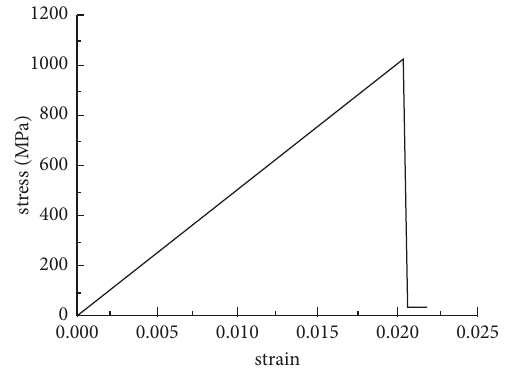
Figure 1: Stress-strain relationship of BFRP